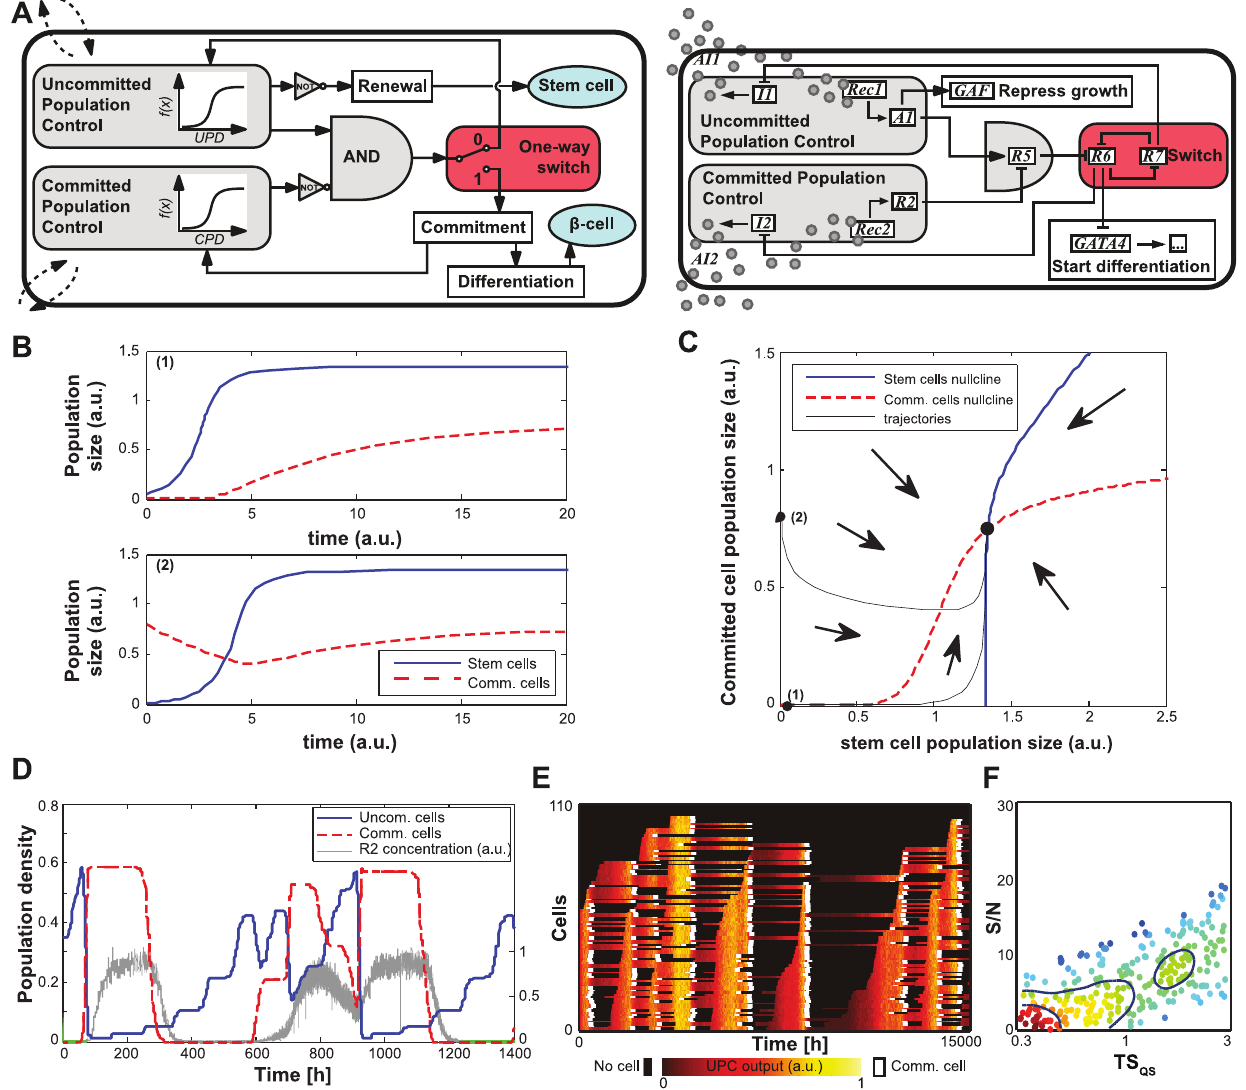
Figure 3. System 2. (A) Circuit diagram: two Population Control modules sense the density of stem and committed cells. The AND gate integrates the output of the modules to induce commitment through the switch state (red module). (B) Deterministic time trajectories for System 2 with two different initial conditions: both converge to the same equilibrium populations. (C) Phase space diagram: all trajectories converge to a unique equilibrium point. Black lines correspond to trajectories plotted in B . See Text S1, Sec. 2 and Figure S3 for other phase space diagrams. (D) Stochastic trajectories for a simulation starting with a small stem cell population, showing the output of the Committed Population Control module ( R 2 ) in representative uncommitted cells (right axis, a.u.). (E) Individual rows track the single-cell UPC module output ( A 1 , shown as a heat map) in uncommitted cells within a population. White signifies single-cell commitment, followed by black ‘‘null space’’ that is filled by newly divided uncommitted cells. As soon as UPC output is high (yellow), stem cells commit en masse . (F) Overall system performance, S/N, as a function of the module time-scale for cell communication, TS QS . Several hundred different sets of time-scales were tested, with all time-scale parameters simultaneously varied. Each point represents an individual set of time-scales. Color and contour lines indicate point density.